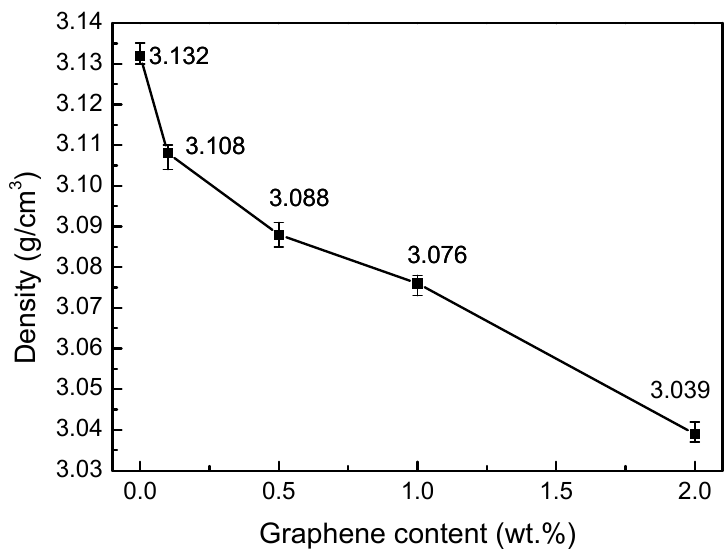
Figure 2. E ff ect of graphene doping on the density of SiC Figure 2. Effect of graphene doping on the density of SiC ceramics.